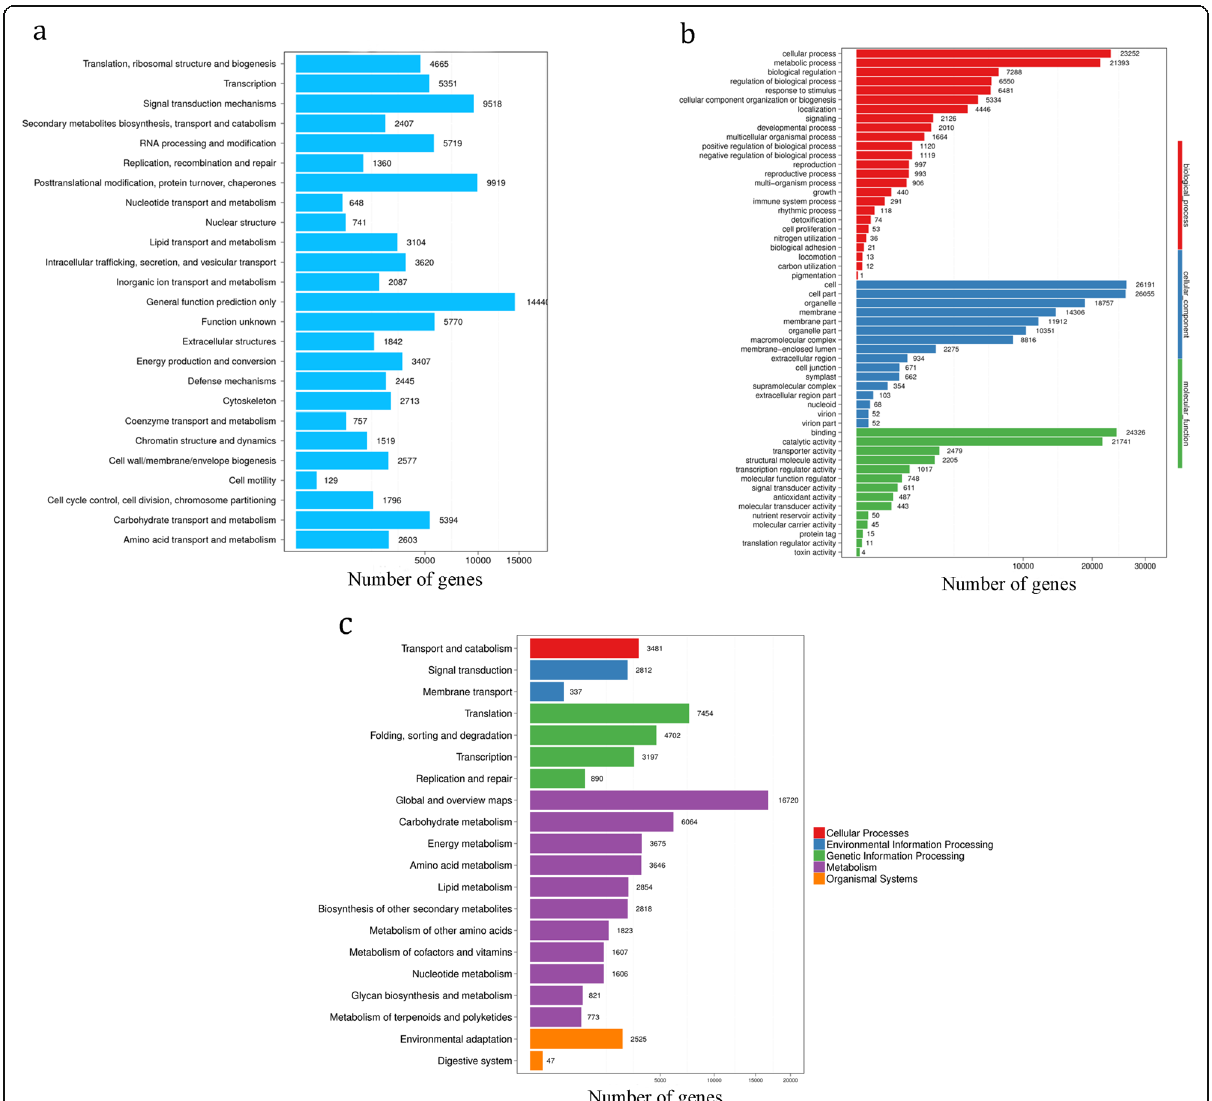
Fig. 1 Functional distribution of KOG, GO, and KEGG annotations of all final isoforms. a Functional distribution of KOG annotations. b Functional distribution of GO annotations. c Functional distribution of KEGG annotations. The X-axis represents the number of transcripts and the Y-axis represents the functional